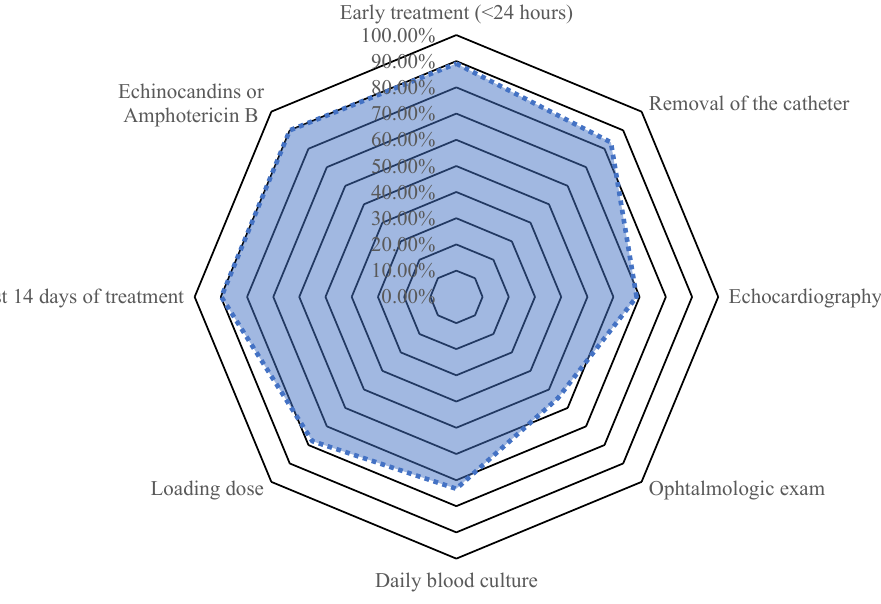
Figure 1. Point-by-point adherence with ESCMID recommendations.